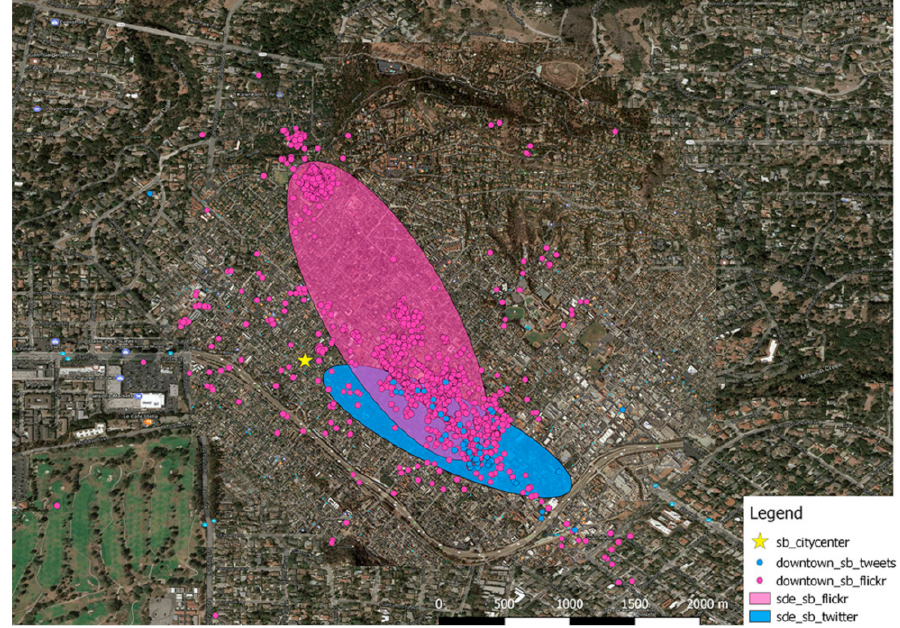
Figure 3. Crowdsourced data from Twitter and Flickr to define the concept of “Downtown Santa Barbara.” Legend: sb stands for Santa Barbara, SDE for Standard Deviational Ellipse , an analysis method to identify the significant points, which is robust to outliers and summarises the central tendency and directional trend of point